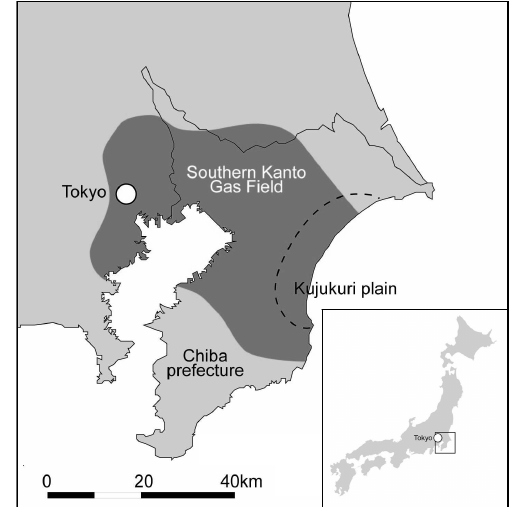
Figure 1. The Southern-Kanto natural gas field.